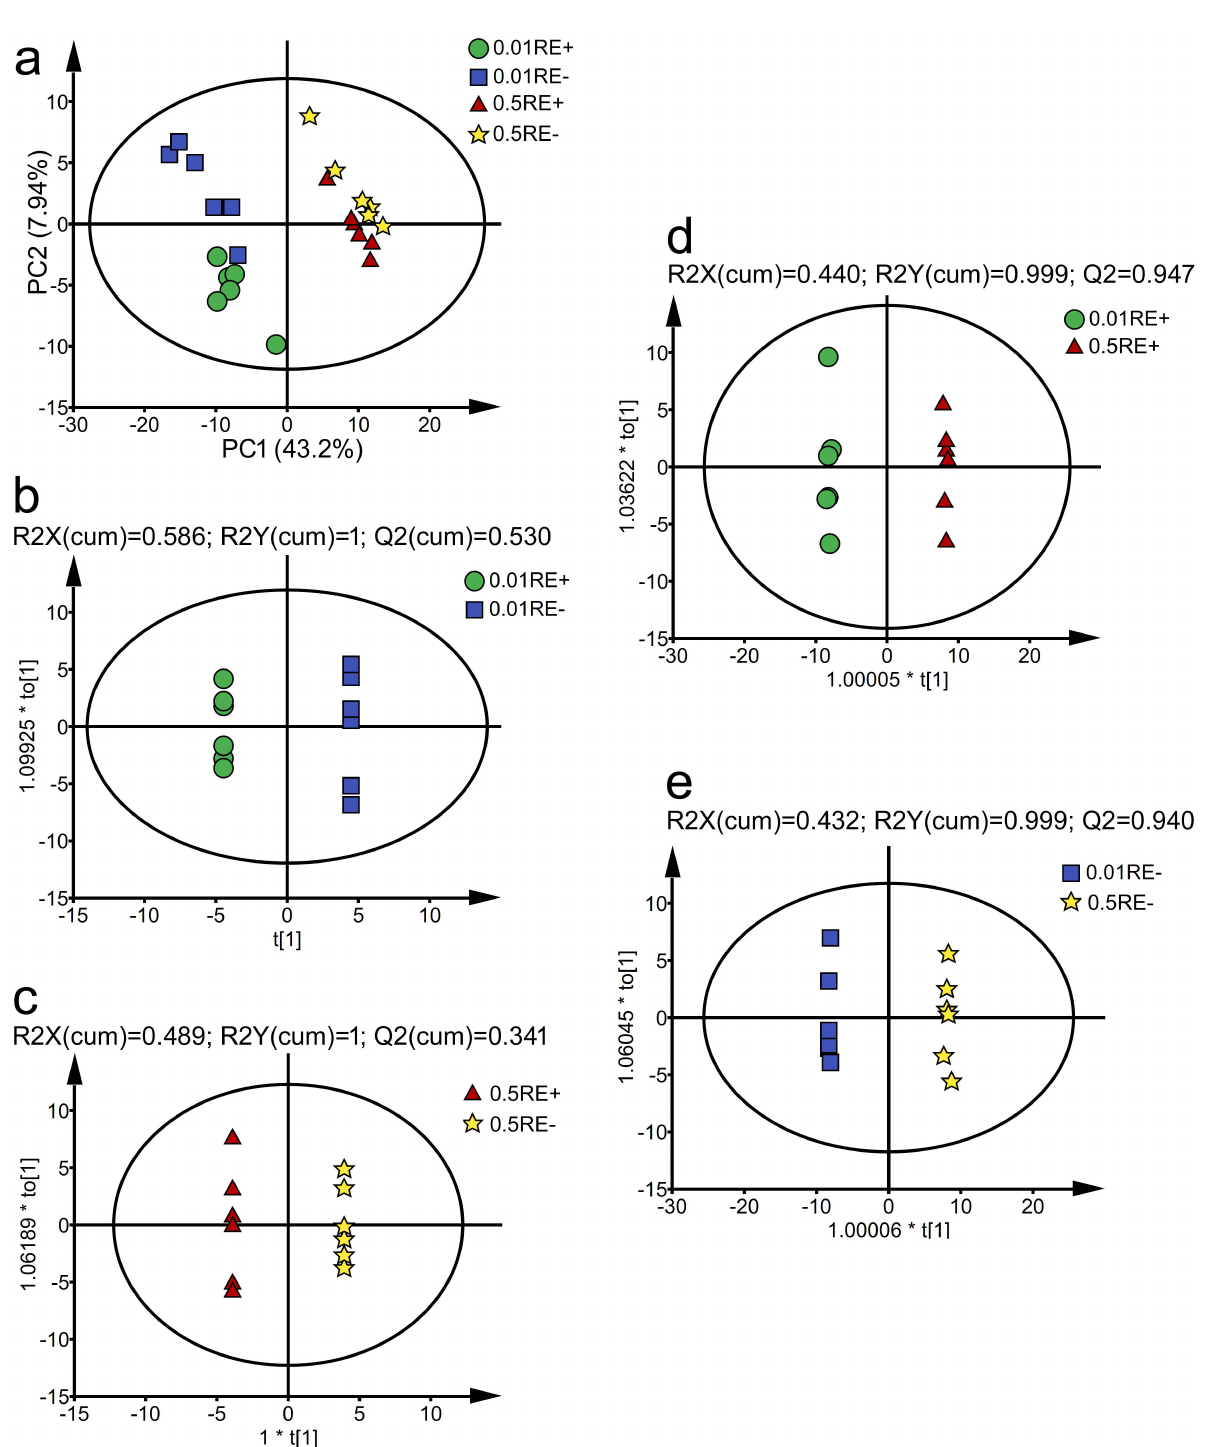
Figure 5. The PCA displayed the metabolic profiles in E+ and E − roots at 0.01 and 0.5 mM P ( a ). OPLS-DA displayed Epichloë gansuensis effects on the metabolism of Achnatherum inebrians roots between RE+ and RE − at 0.01 mM P ( b ), between RE+ and RE − at 0.5 mM P ( c ); and dose-dependence of P effects on the metabolism of Achnatherum inebrians roots between 0.01 and 0.5 mM P in RE+ ( d ), between 0.01 and 0.5 mM P in RE − ( e ). RE+: E+ roots, RE − : E −